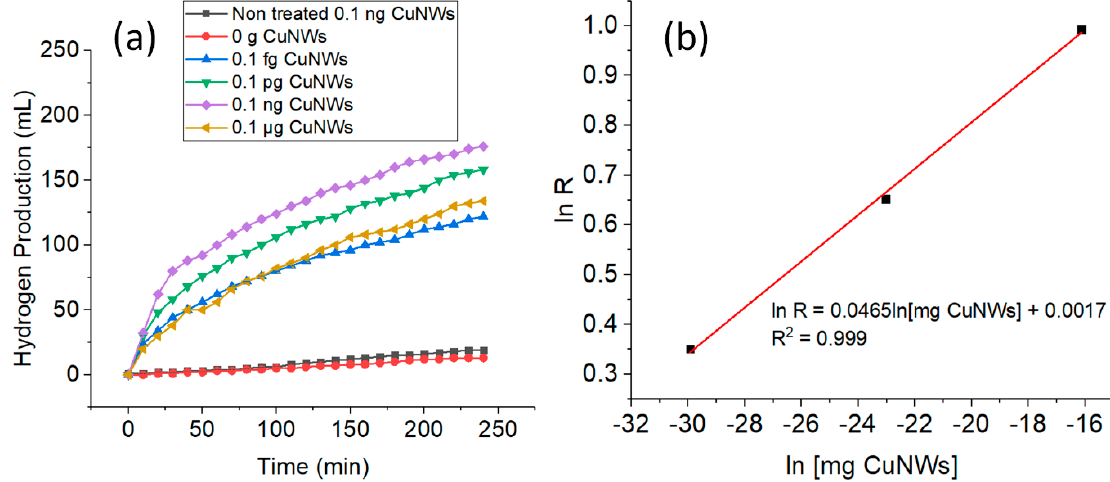
Figure 2. Plot of ( a ) different copper nanowires’ (CuNWs) loadings on H 2 generation versus time; and ( b ) HGR versus CuNWs’ loadings, both in logarithmic scale. (Conditions: 10 mL of [NaBH 4 ] = 1 wt%, pH = 12, and temperature = 298 K).